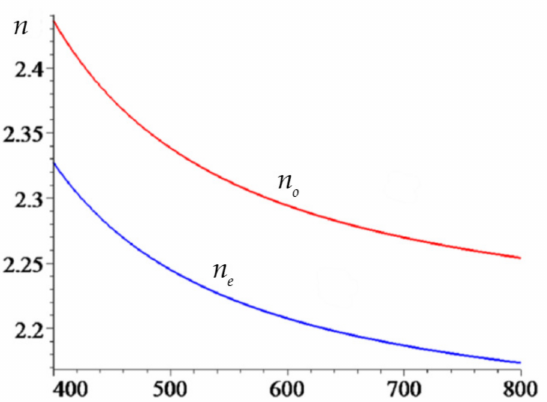
Figure 2. Spectral dependence of the refractive index n o , e on the wavelength of the visible range in a lithium niobate crystal.